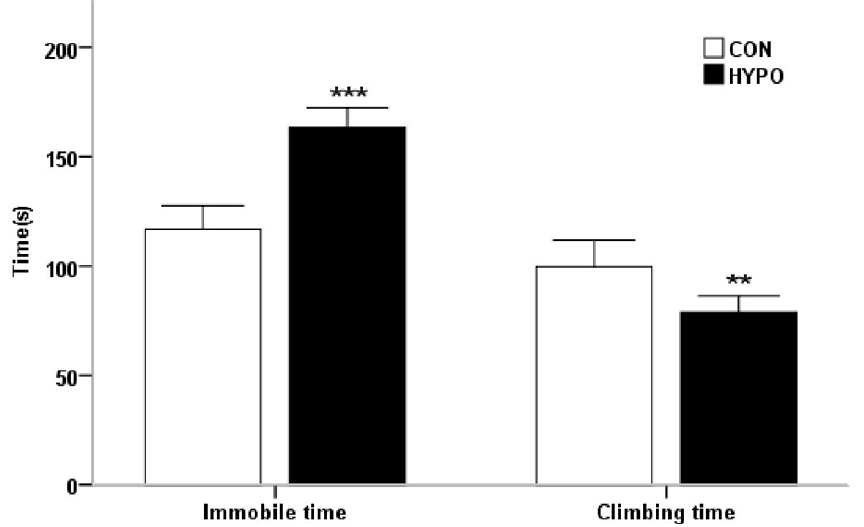
Figure 1. Behavior of the control group (n = 10) and hypothyroid group (n = 10) in the forced swimming test (FST) 5 weeks after PTU administration. Comparison of time spent climbing and time spent immobile. (** p < 0.01, *** p <